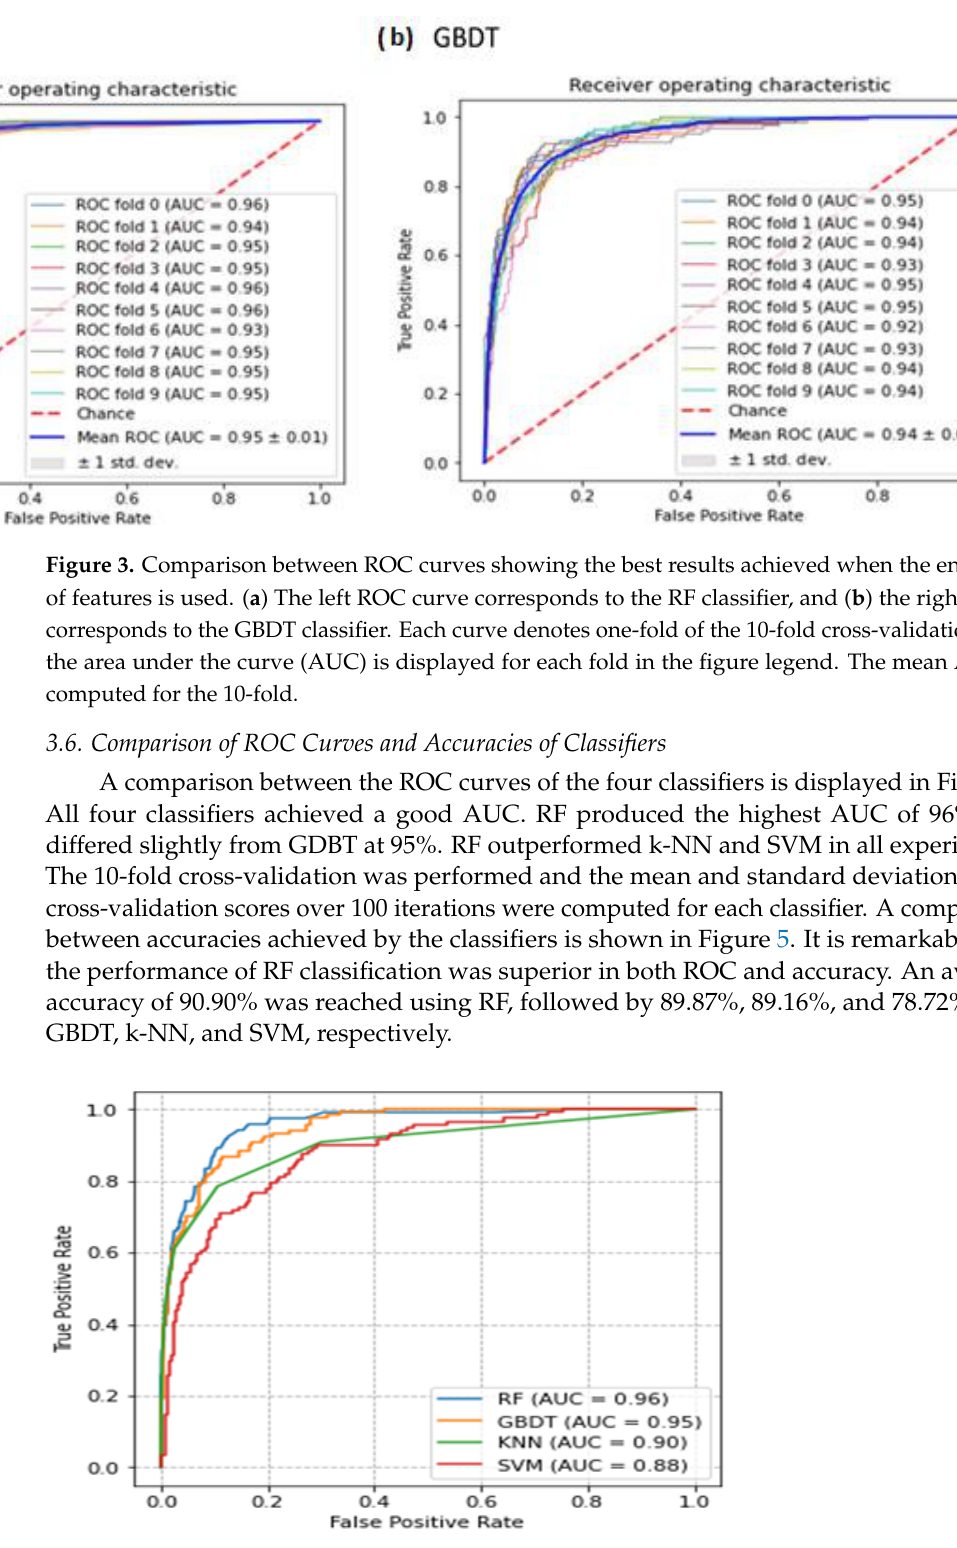
Figure 5. Box plots corresponding to the accuracy of the classification of the two classes of seizure and seizure-free. The orange line in the boxes marks the median. The final accuracy score is deter- mined by averaging the 10 ROC curves and calculating the AUC of the mean ROC. 4. Discussion This study addressed the problem of seizure vs. seizure-free EEG record classifica- tion. The classifier design and validation used data from 341 subjects in the TUSZ data- base, a larger amount of data than previously used. Several studies have highlighted the advantage of complexity measures as EEG sig- nal description in seizure detection [2,4,5,9–11,13,15,19,20], and others showed the im- portance, as well, of signal power in different frequency bands [3,7,8,19]. We inquired into